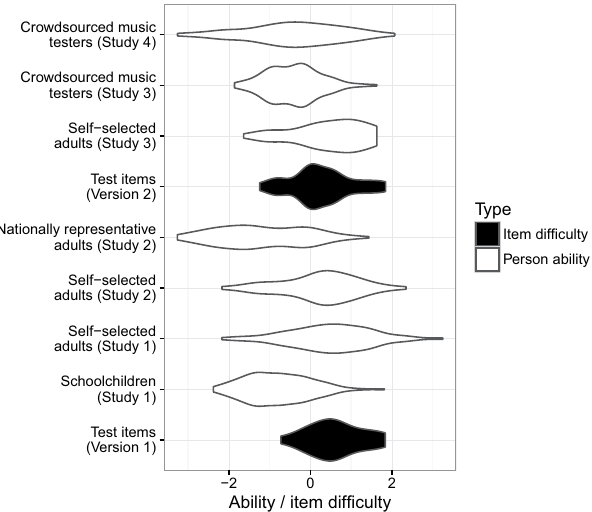
Figure 3. Person ability and item difficulty distributions for the four studies and two test versions. As is conventional, the widths of the ‘violins’ are proportional to the densities of the smoothed